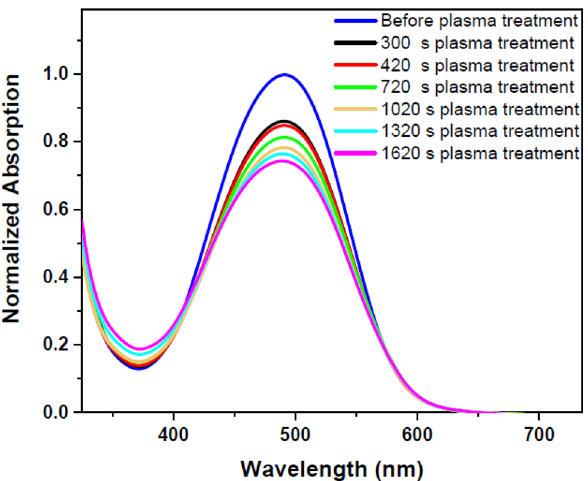
Figure 2. UV–Vis spectra of pristine and argon plasma-treated DR1 dye-doped PMMA polymer film for various treatment